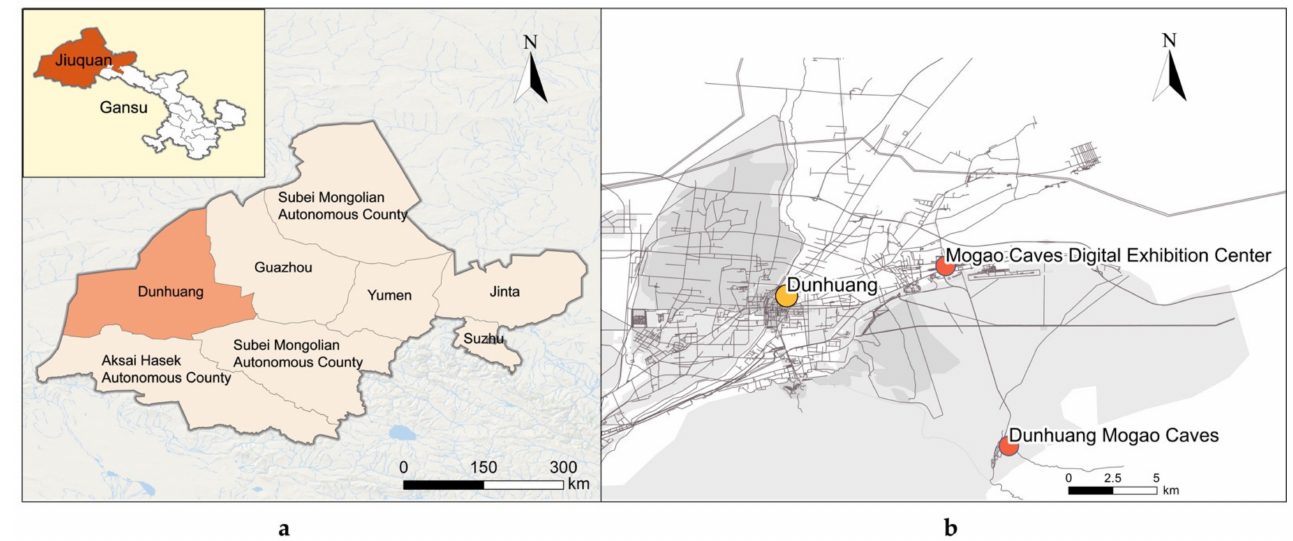
Figure 2. ( a ) Dunhuang location map. ( b ) Dunhuang Mogao Caves location